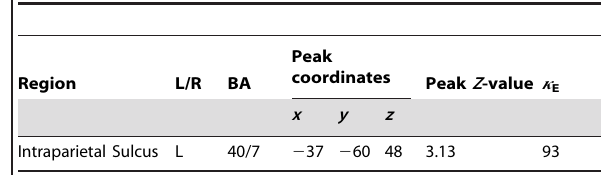
Table 3. Regions showing a significant correlation between the degree of TOJ reversal and fMRI signal changes in the Crossed L condition, compared to the Uncrossed condition, when the participants’ eyes were